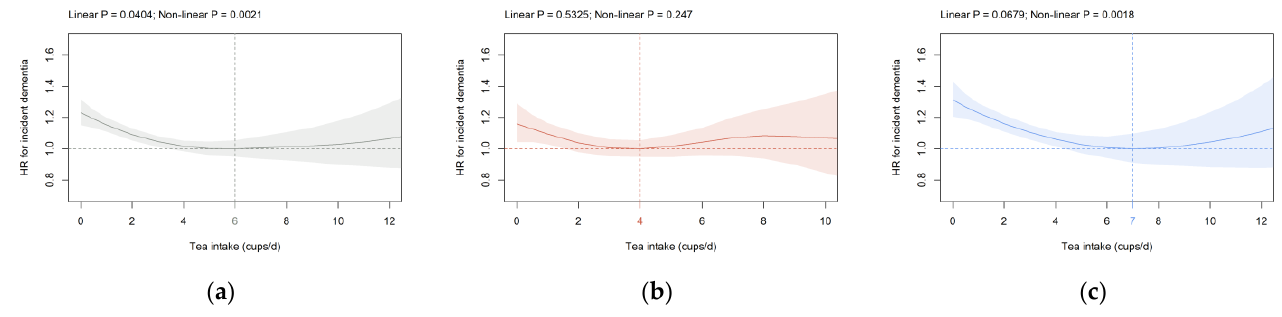
Figure 4. Association of tea intake (cups/d) with dementia risk in the primary cohort in ( a ) all participants, ( b ) females, and ( c ) males. Data are adjusted and presented as indicated in Figure 1.